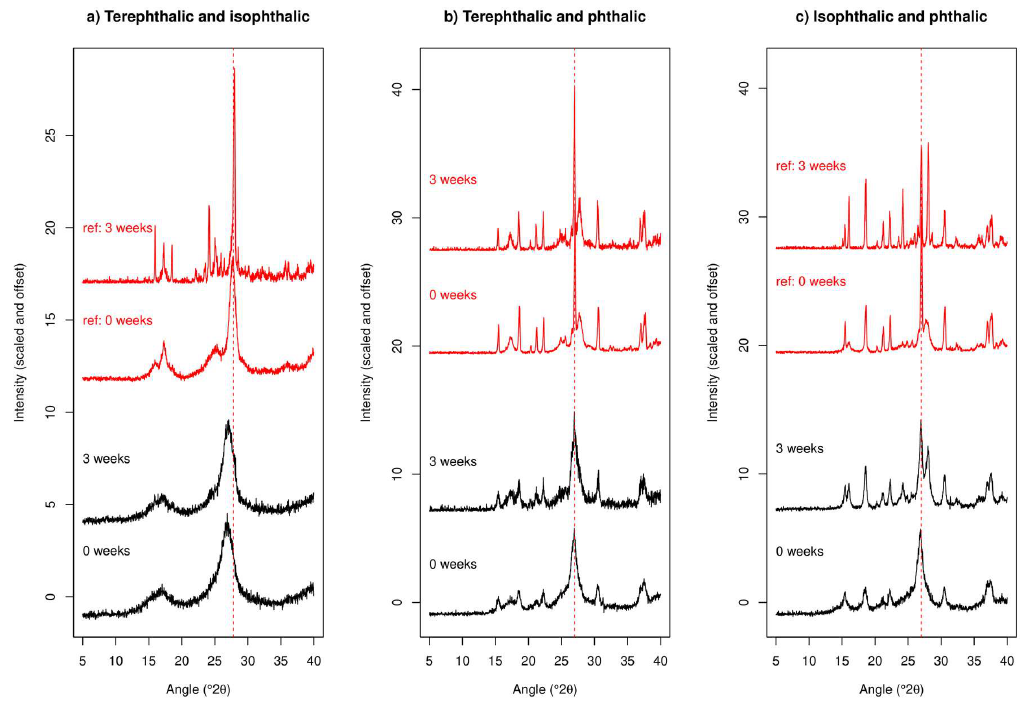
Figure 6. XRPD data for co-cryo-milled combinations of ( a ) TPA, ( b ) IPA and ( c ) PA as labelled. Red lines indicate the peak positions of the most intense peaks of the reference materials (freshly cryo-milled individual components) which are labelled “ref” and shown in red.